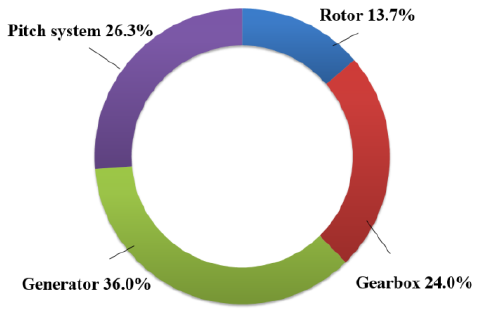
Figure 6. The proportion of costs.